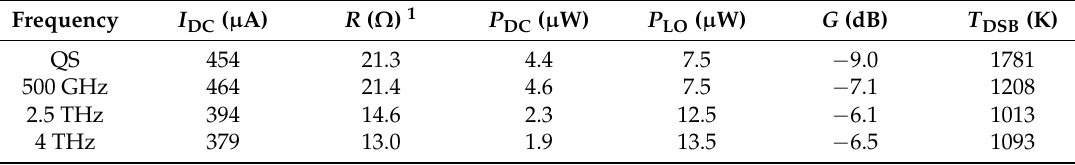
Table 2. For an HEB of dimensions L = w = 400 nm and θ = 35 nm at different operating frequencies, with matching coefficient α imp included, compared performances at an optimal operating point with respect to the noise